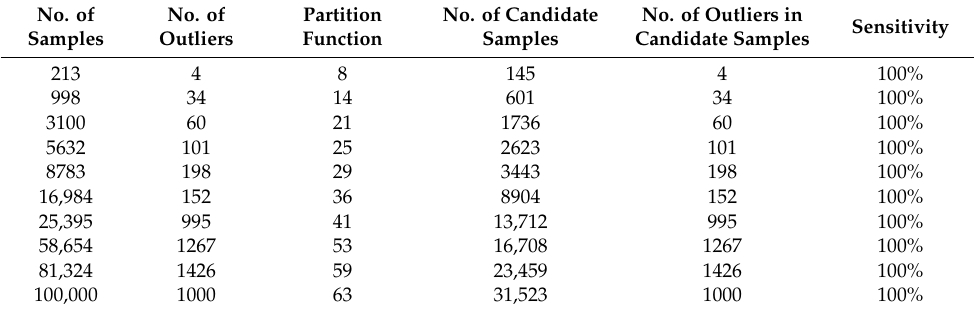
Table 3. The summary of 10 datasets ( | N | = 213–100,000) after dataset optimization.